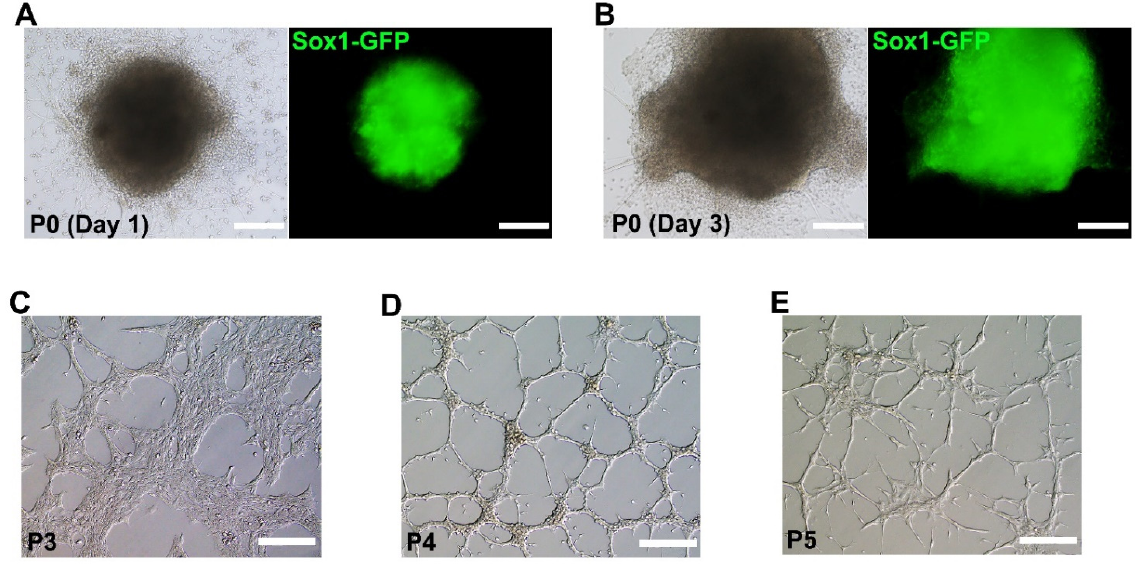
Figure 2. Establishment of neural stem cells (NSCs) using Sox1 -GFP-expressing aggregates. GFP-expressing aggregates attached onto a gelatin-coated dish on day one ( A ) and day three ( B ) after transferring to a new dish. ( C ) NSCs established from aggregates at passages (P) 3, 4, and 5 showed typical NSC morphology ( C , D , and E , respectively). Scale bars = 200 µ